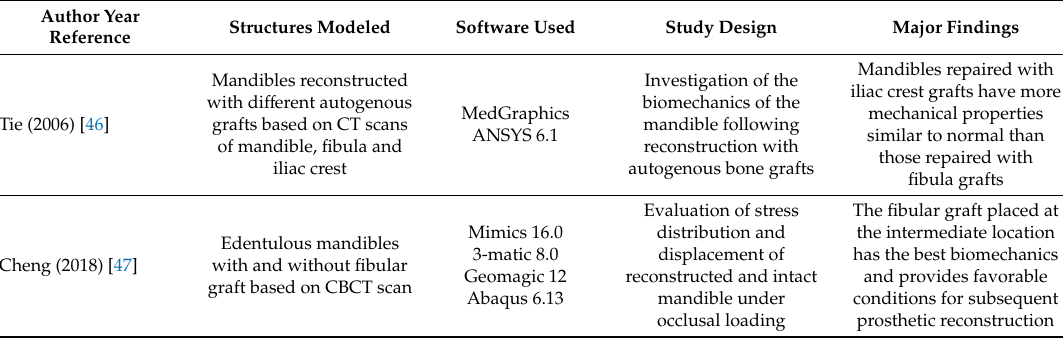
Table 3. Information regarding FEA conducted in the field of reconstructive surgery.